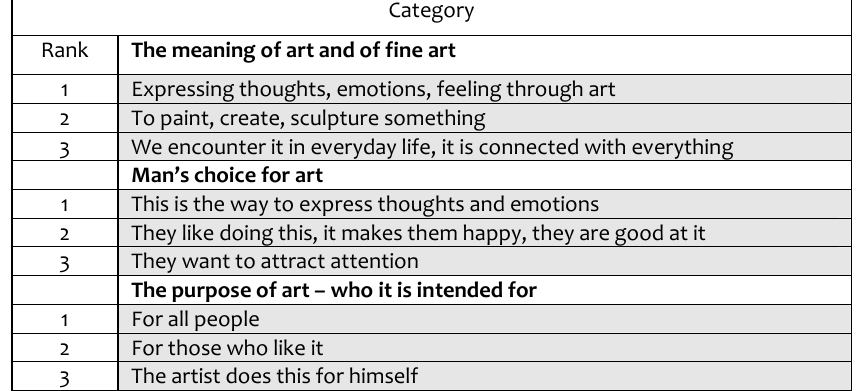
Table 1: Ranking order of the categories of answers of all participating groups linked to the question about the attitude of pupils toward art and fine